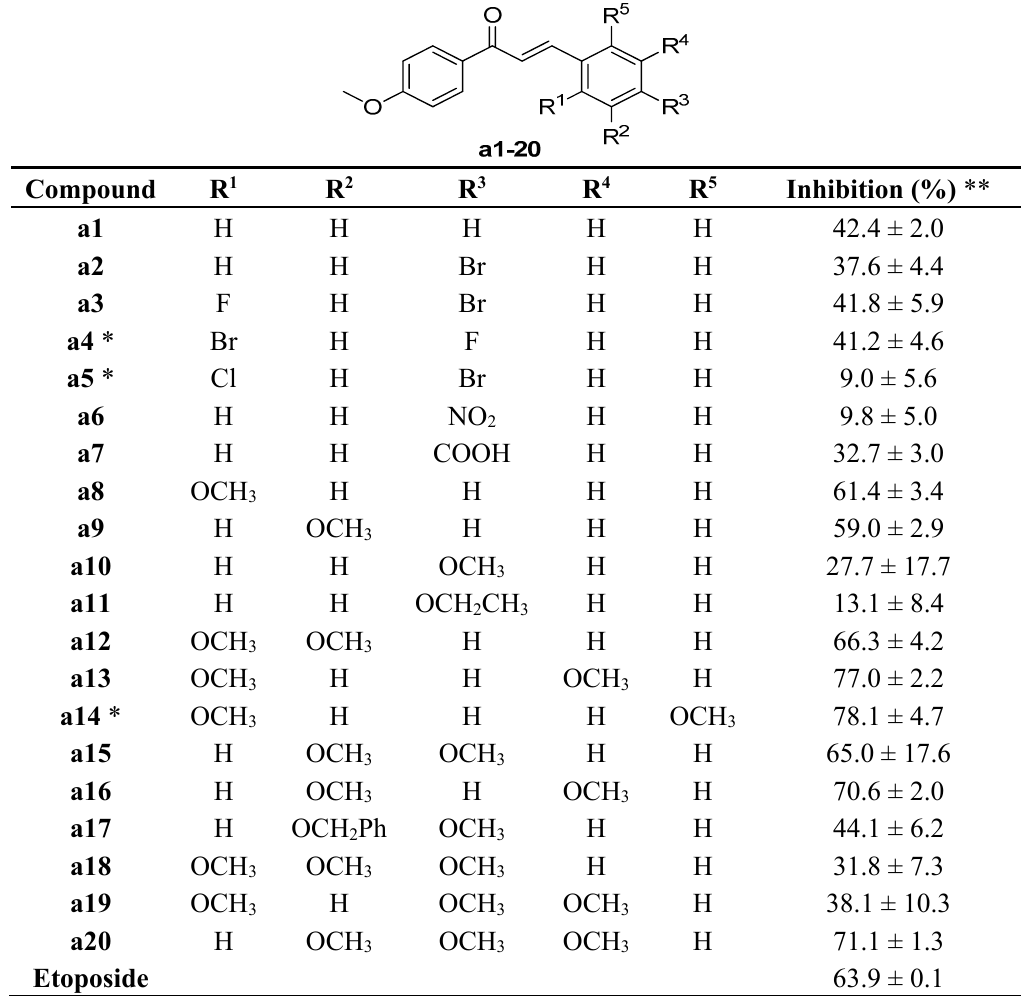
Table 1. Inhibitory activities of the 4-methoxyl chalcones a1 – 20 against HepG2 cells (10 μ